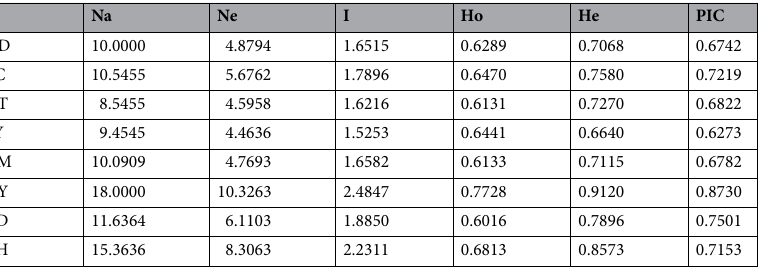
Table 2. Genetic diversity statistics of eight L. maculatus populations. LY Lieyu, CM Chongming, DT Dongtou, QD Qingdao, FC Fangcheng, GY Ganyu, RD Rudong, BH Binhai, Na observed number of alleles, Ne expected number of alleles; I shannon wiener index, Ho observed heterozygosity, He expected heterozygosity, PIC polymorphic information content.